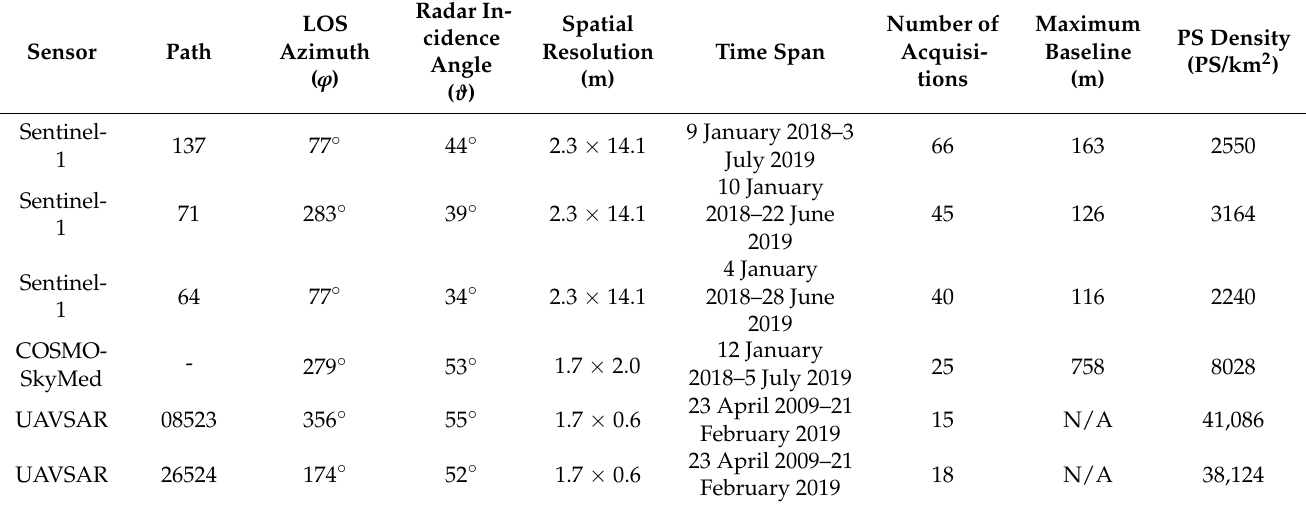
Table 1. Information of the Sentinel-1, COSMO-SkyMed and UAVSAR